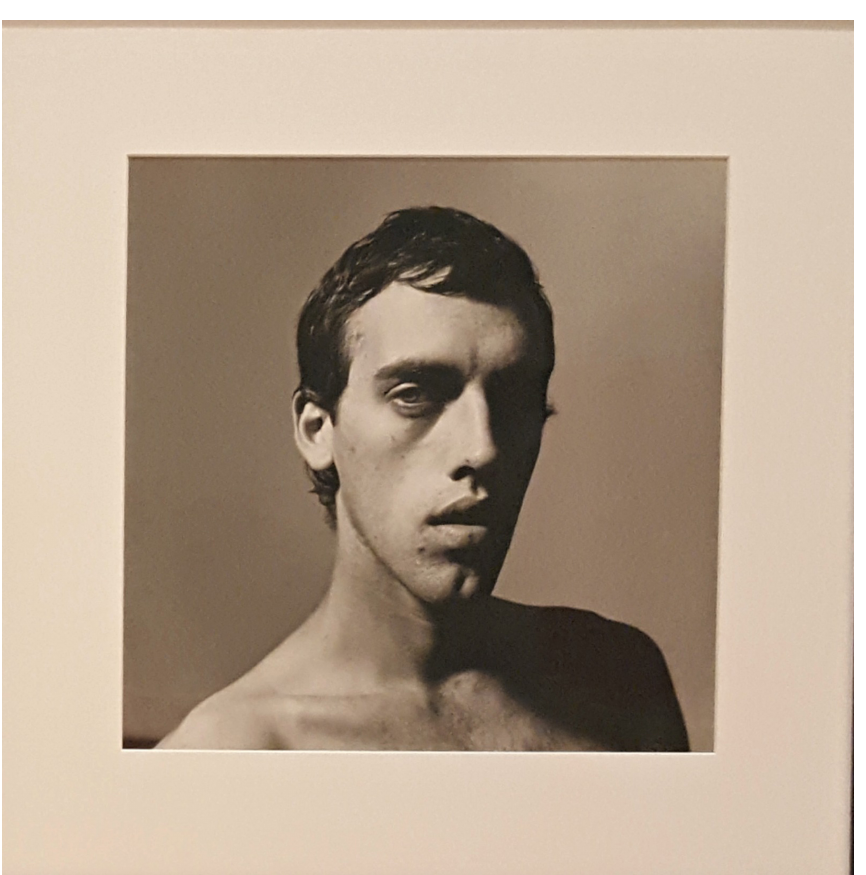
Figure 3: David Wojnarowicz , Peter Hujar, 1981. Photo by Paul R. Abramson,